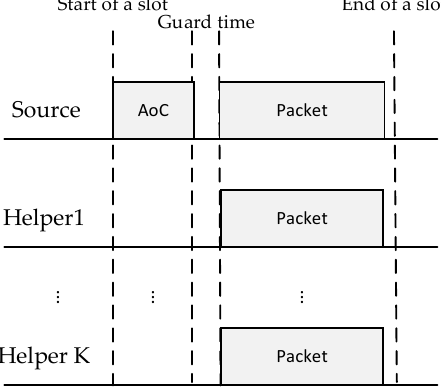
Figure 6. Cooperative retransmission.